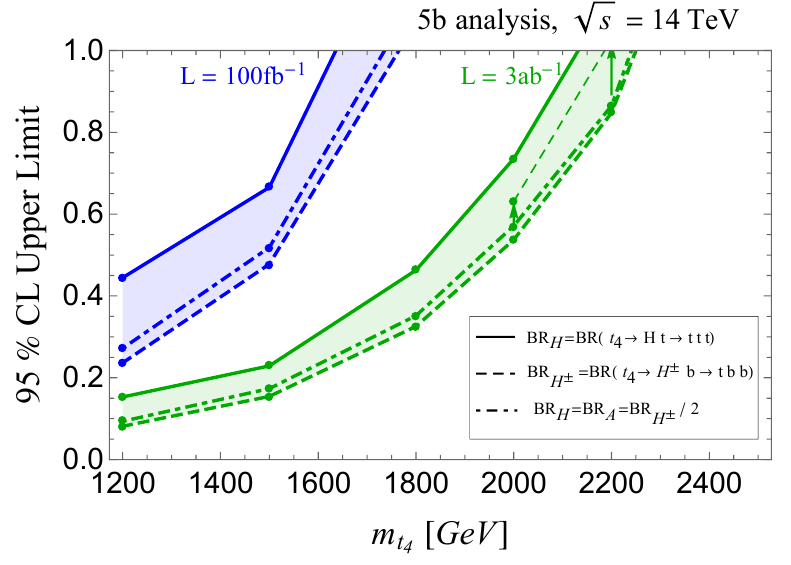
Figure 11 . Expected 95% CL upper limits on the t 4 branching ratio into neutral or charged Higgses in the 5b analysis. Styling of all curves matches that in (cid:12)gure